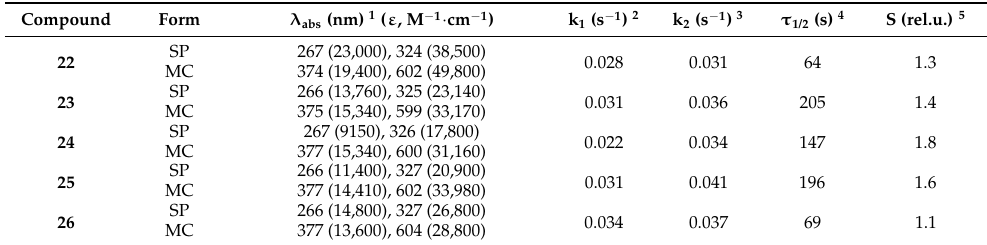
gated system in the electronic ground state of the molecule. Table 1. Spectral and kinetic characteristics of the studied photochromic compounds in spiropyran (SP) and merocyanine (MC) forms.